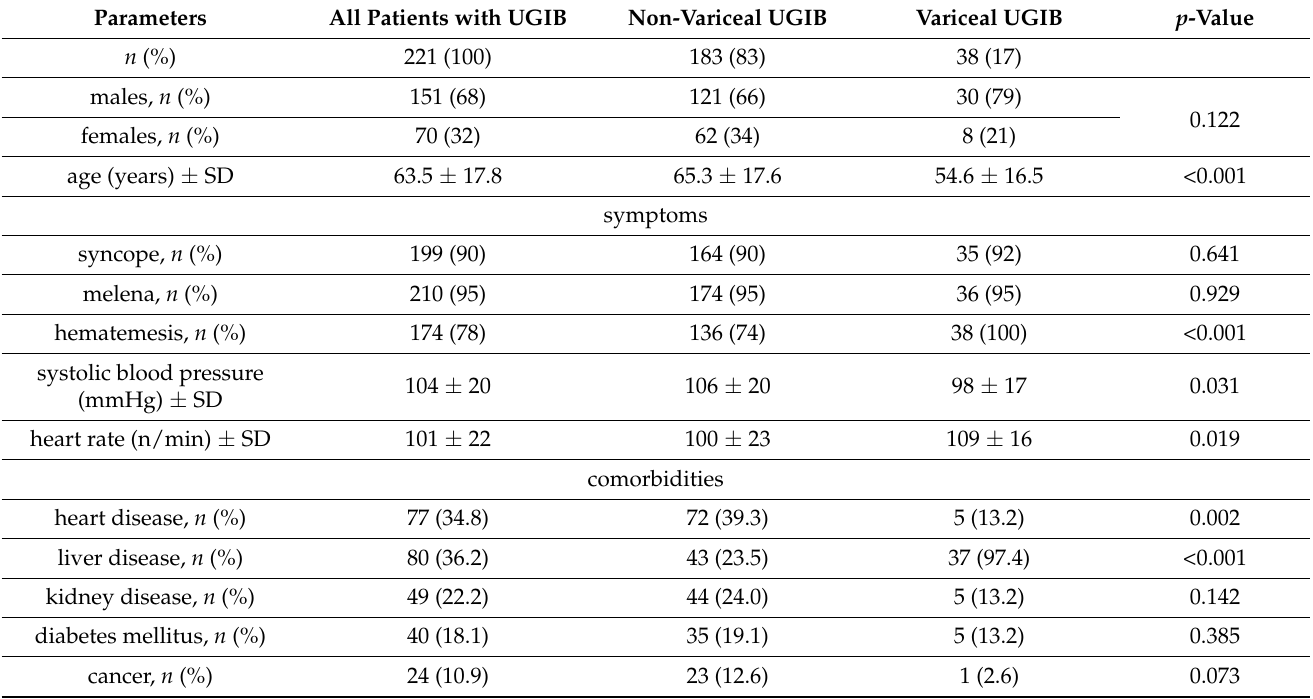
Table 1. Characteristics of patients hospitalized for upper gastrointestinal bleeding (data presented as numbers, percentages or means ±